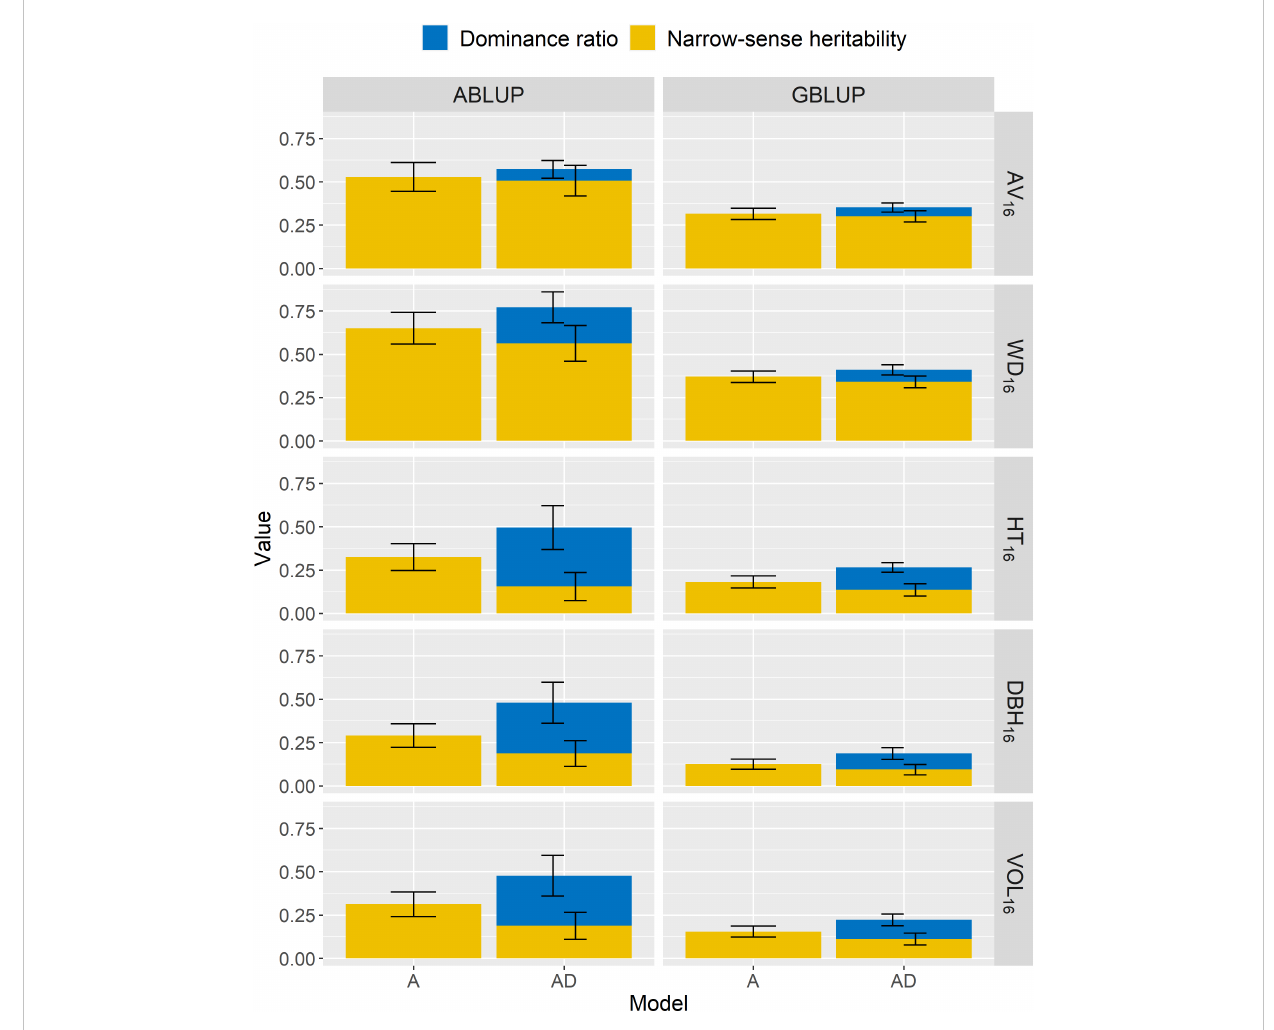
FIGURE 2 For the complete dataset 1, across-site narrow-sense heritabilities ( ^ h 2 ind ) and dominance ratios ( ^ d 2 ind ) estimated using additive (A) or additive- dominance (AD) models, with ABLUP or GBLUP. The broad-sense heritabilities ( ^ H 2 ind ) are estimated as the sum of ^ h 2 ind and ^ d 2 ind . The error bars represent the approximated standard errors of estimates calculated using the delta method. See Table 2 for a description of